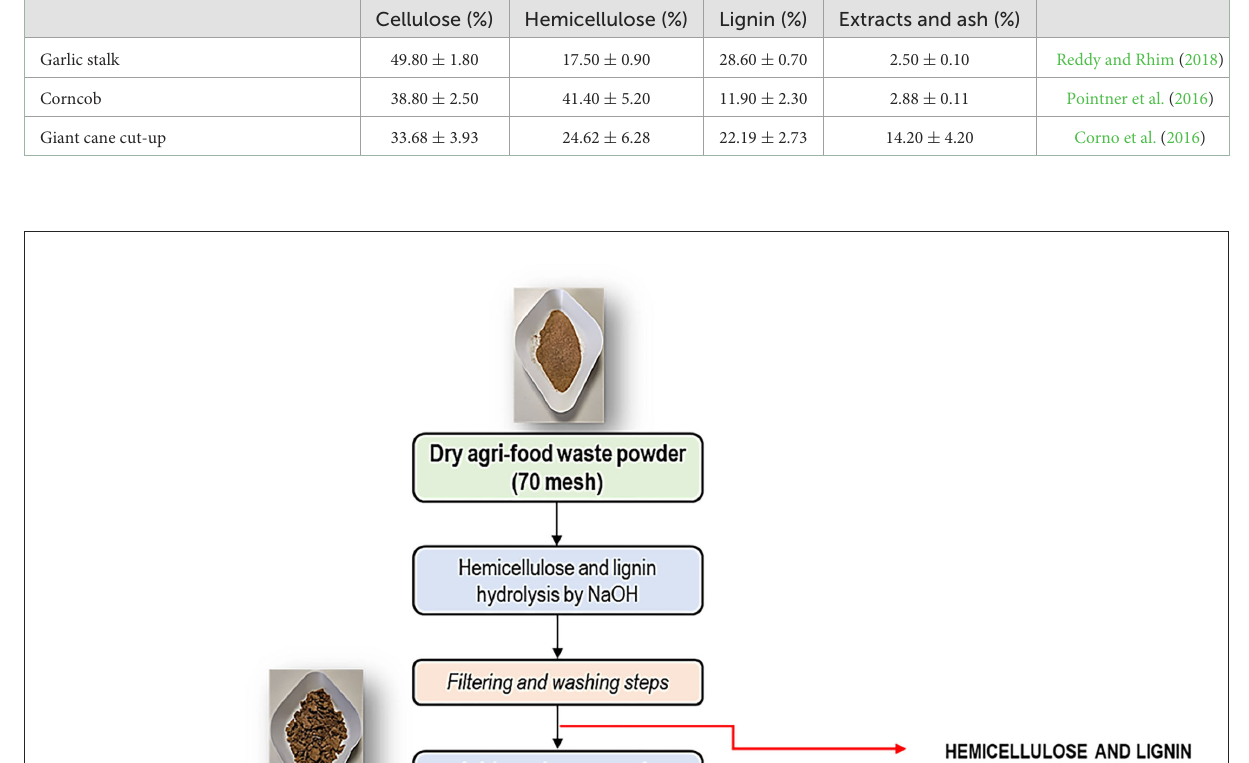
FrontiersinSustainableFoodSystems